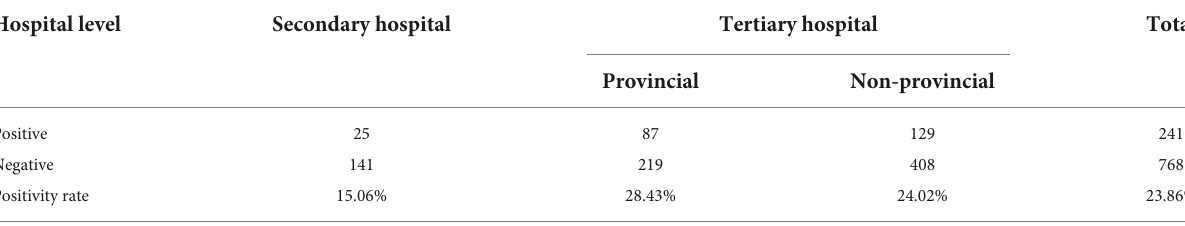
TABLE 6 CRE positive rates in different level